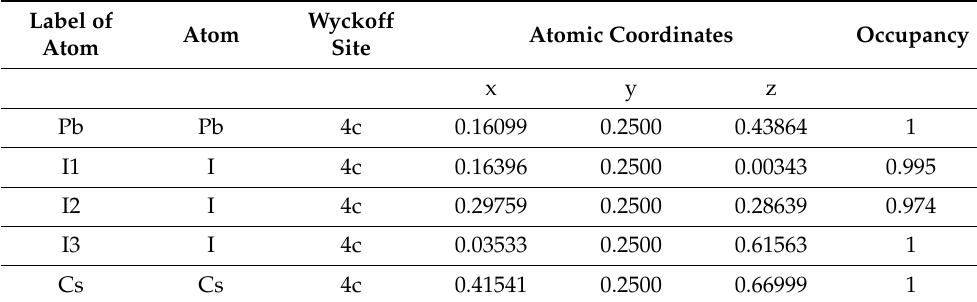
Figure 1. Rietveld refinement of the XRD pattern of δ -CsPbI 3 at room temperature. Table 1. At room